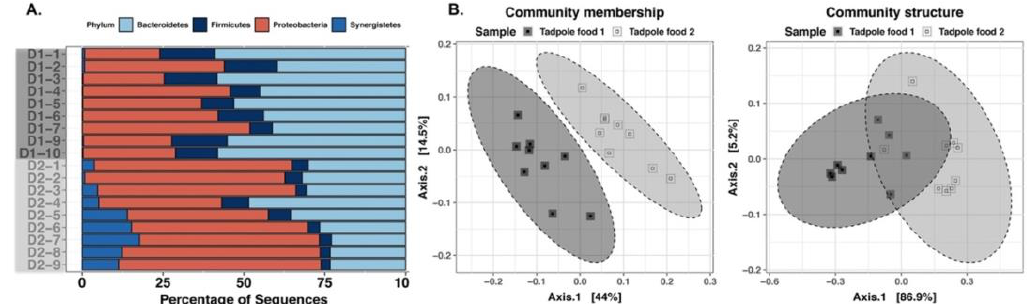
Figure 5. Influence of tadpole’s diet on their gut microbiome. A. Bar plot representation of bacterial diversity at the phylum level. B. Principal coordinate analysis of microbial communities across several adult organs and samples. Community membership was analyzed using unweighted UniFrac distance, and community structure was analyzed using weighted UniFrac distance. Percentages of the explained variations are indicated on both axes. Tadpole Food 1 (D1 samples) was a micro planktonic-based diet and tadpole food 2 (D2 samples) (food 1) was a sterile